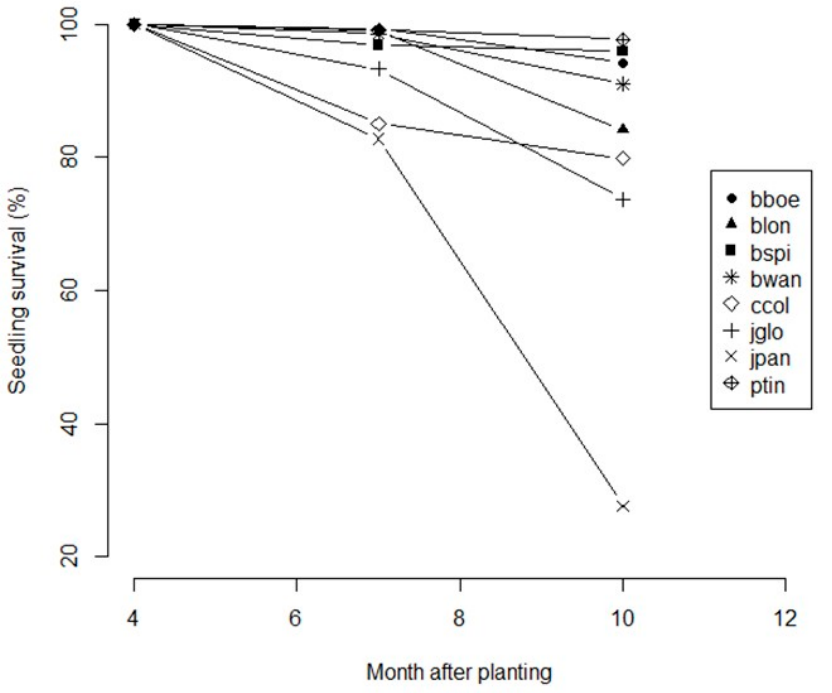
Figure 2. Survival of seedlings of 8 trees species of woodland, 4 to 10 months after planting (dry season: 30 March 2011 to 30 September 2011, corresponding to the dormancy period of the trees). ccol: C. collinum and ptin: P. tinctorius (ES); bboe: B. boehmii , blon: B. longifolia , bspi: B. spiciformis , bwan: B. wangermeana , jglo: J. globiflora and jpan: J. paniculata (LS). N = 6 replicates (subplot) per species.